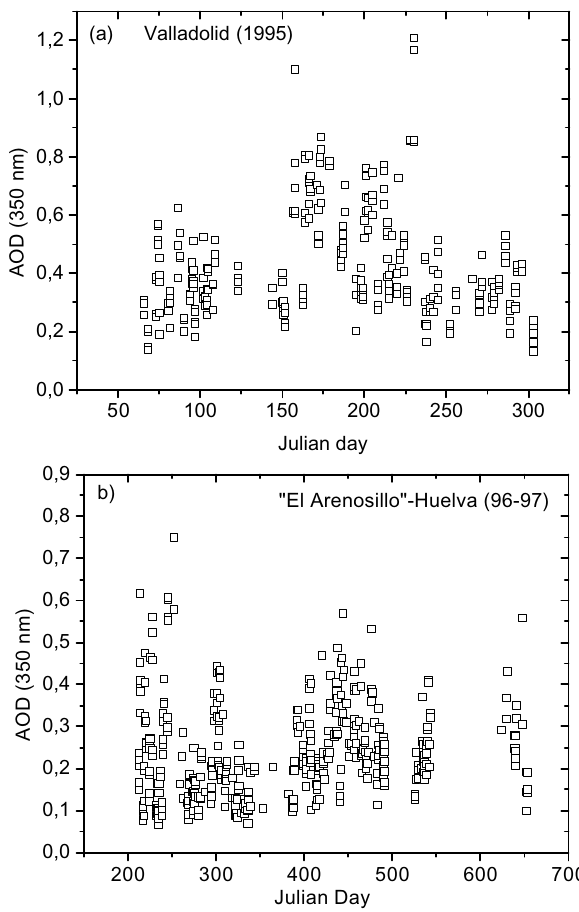
Fig. 1. Temporal evolution of the experimental AOD at 350nm for the a data of the north central station of Valladolid and b southwest coastal station of “El